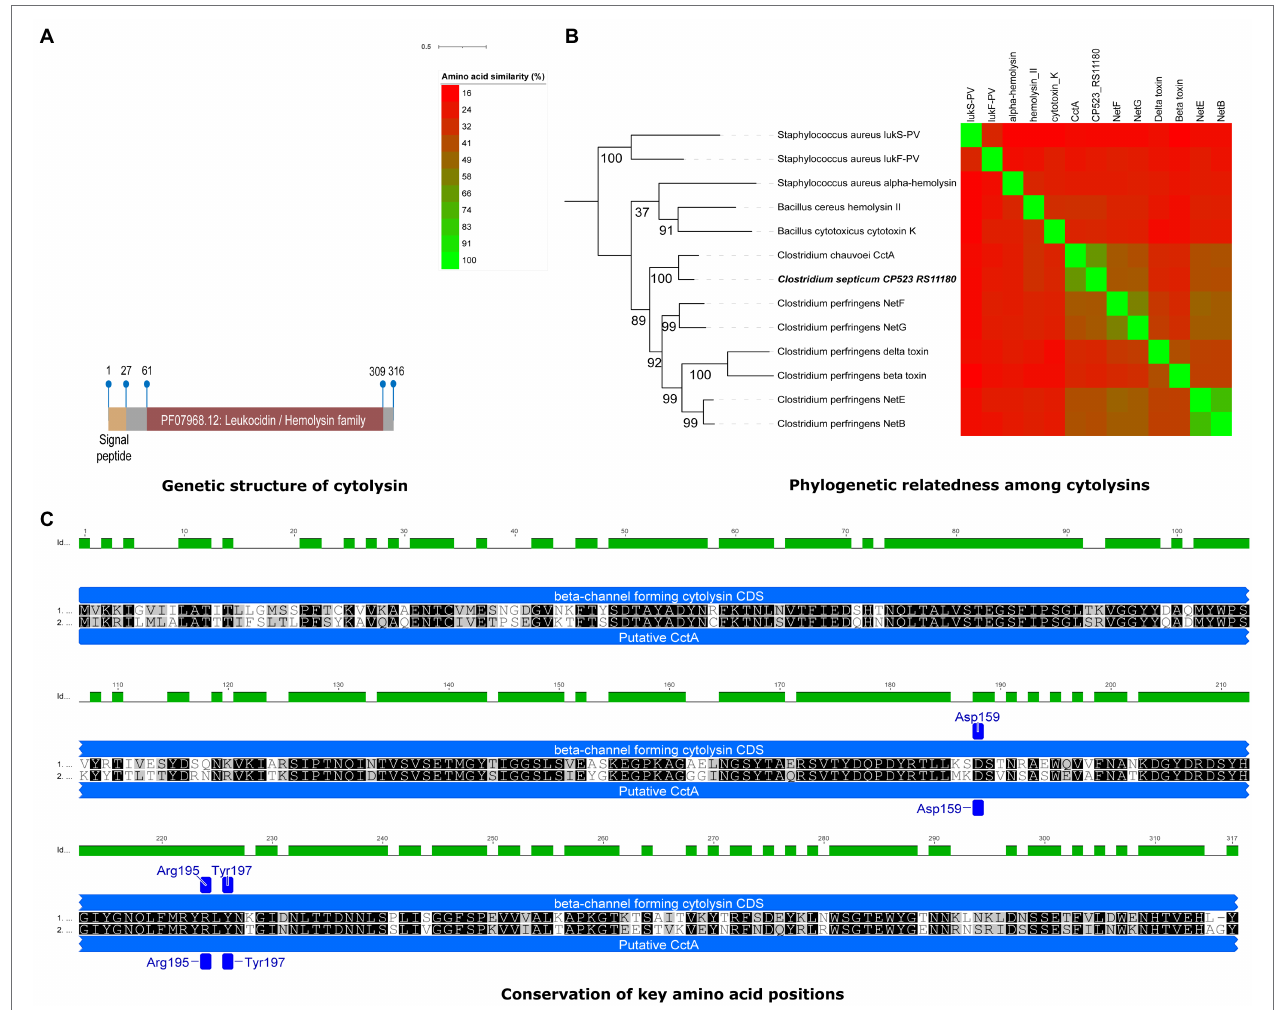
FIGURE 6 | Novel cytolysin identified in C. septicum genomes. (A) Genetic structure of novel cytolysin identified in C. septicum with respect to genetic structure such as signal peptide and Leucocidin/Hemolysin toxin domain. (B) Phylogenetic relatedness of cytolysin to C. chauvoei CctA (100% boostrap support value) and other pore forming toxins in related species. (C) Conservation of key amino acid positions in C. septicum cytolysin (upper) with C. chauvoei CctA (lower) reported for